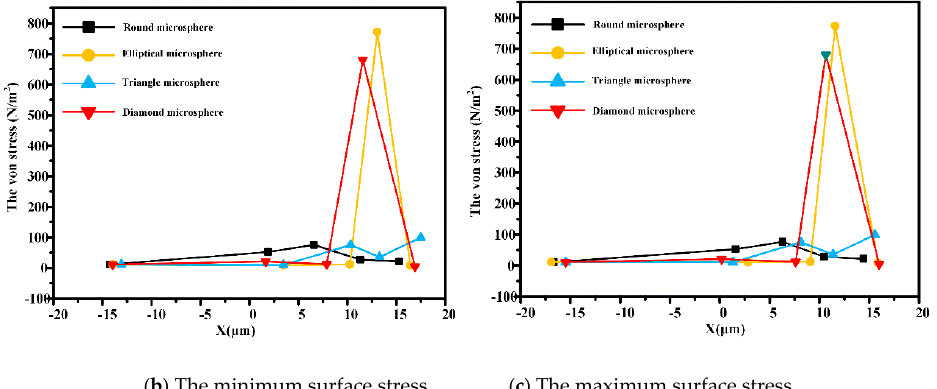
Figure 7. The surface stress on round, elliptical, triangular and rhomboid microspheres (at t =0 s, 0126 s, 0.156 s, 0.171 s, and 0.19 s). (a) The microspheres are in different positions at five moments. The minimum and maximum stresses (von stress) are shown in ( b ) and ( c ), respectively.